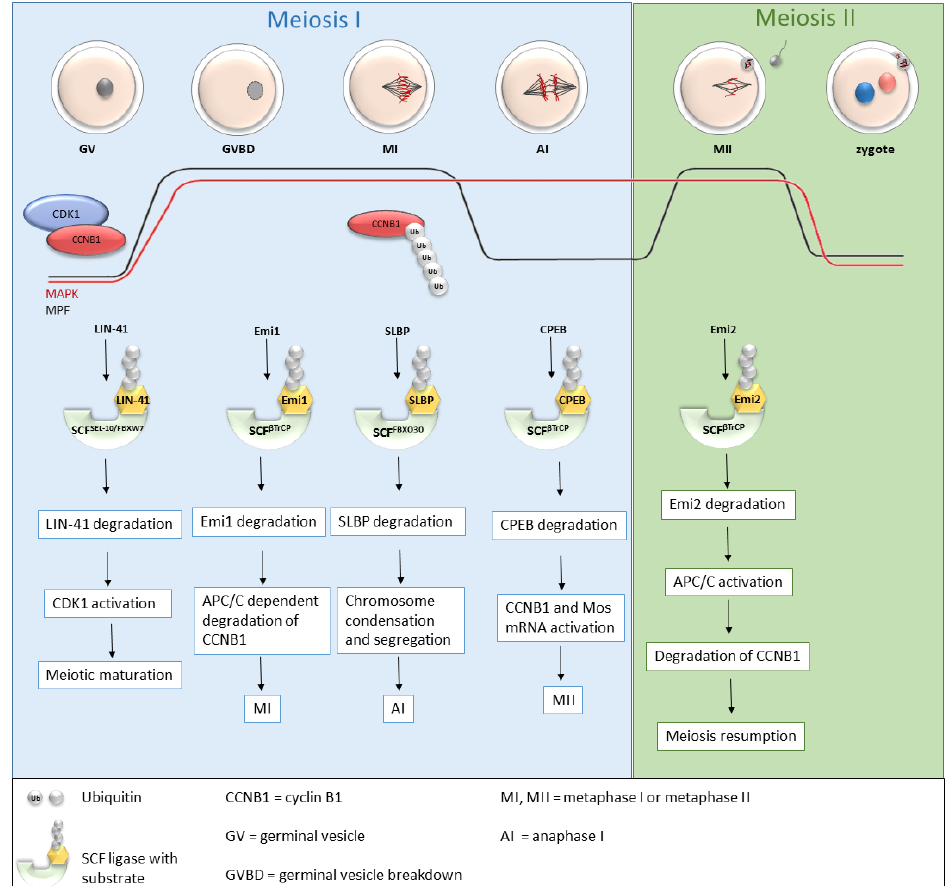
Figure 3. Roles of selected SCF ligases in oogenesis. Progression through oogenesis is mediated by MAPK and MPF (composed by CDK1 and CCNB1) activity which is graphically represented by red and black curves. Activation of CDK1 is regulated by a cyclic activity of CCNB1, whose degradation is mediated via ubiquitination by APC/C. The level of MAPK is stable to the metaphase II. SCF SEL-10/FBXW7 , SCF β TrCP and SCFFBXO30-mediated degradation of their targets is essential for progression through meiosis I and meiosis II stages of mouse, C. elegans and Xenopus oocytes. AI—anaphase I,